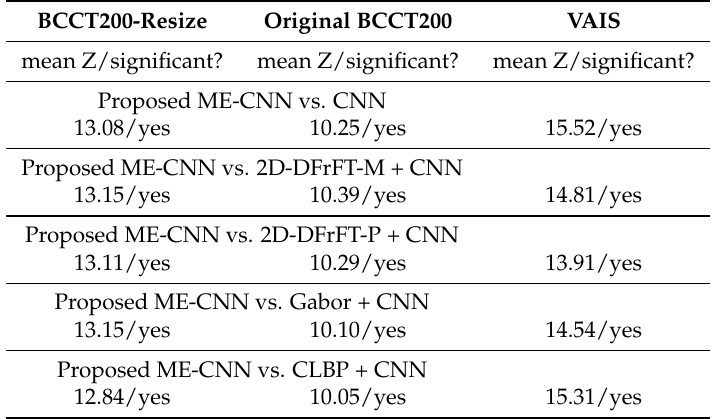
Table 12. Statistical significance evaluated by the McNemar’s test based on difference between